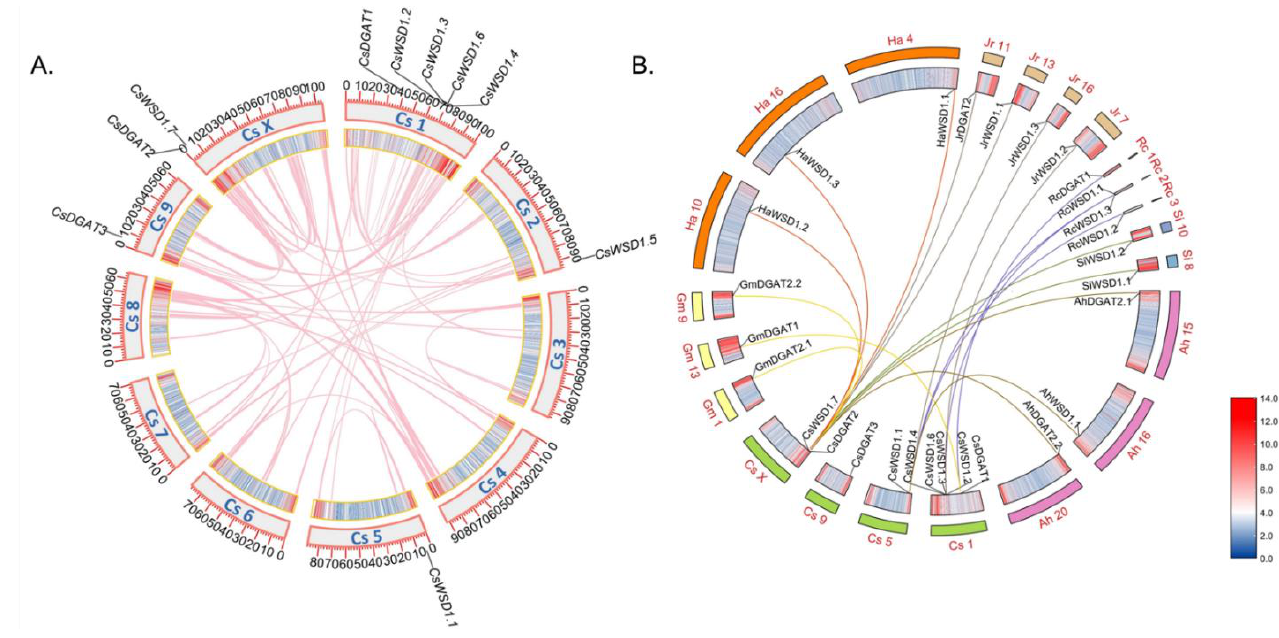
Figure 2. Chromosomal location and synteny analysis of CsDGATs in C. sativa genome. ( A ) Chro- mosomal locations of CsDGATs . Tandem-duplicated genes are indicated with red boxes, and the chromosome number is indicated above each chromosome. The scale is in megabases (Mb). ( B ) Syntenic relationship of CsDGATs . The annotations on the fragments represent different chromosomes, and the numbers in the outermost circle represent the positions of the corresponding chromosomes. The CsDGATs involved in segmental duplications in the CsDGATs gene family are mapped to their respective locations of the C. sativa genome in the circular diagram. The different color lines represent the segmental duplication pairs between the CsDGATs and the DGAT gene of other plant genomes. Gm , Glycine max (yellow font), Ha , Helianthus annuus (orange font), Jr , Juglans regia (grey font), Rc , Ricinus communis (blue font), Si , Sesamum indicum (green font), Ah , Arachis hypogaea (brown font).